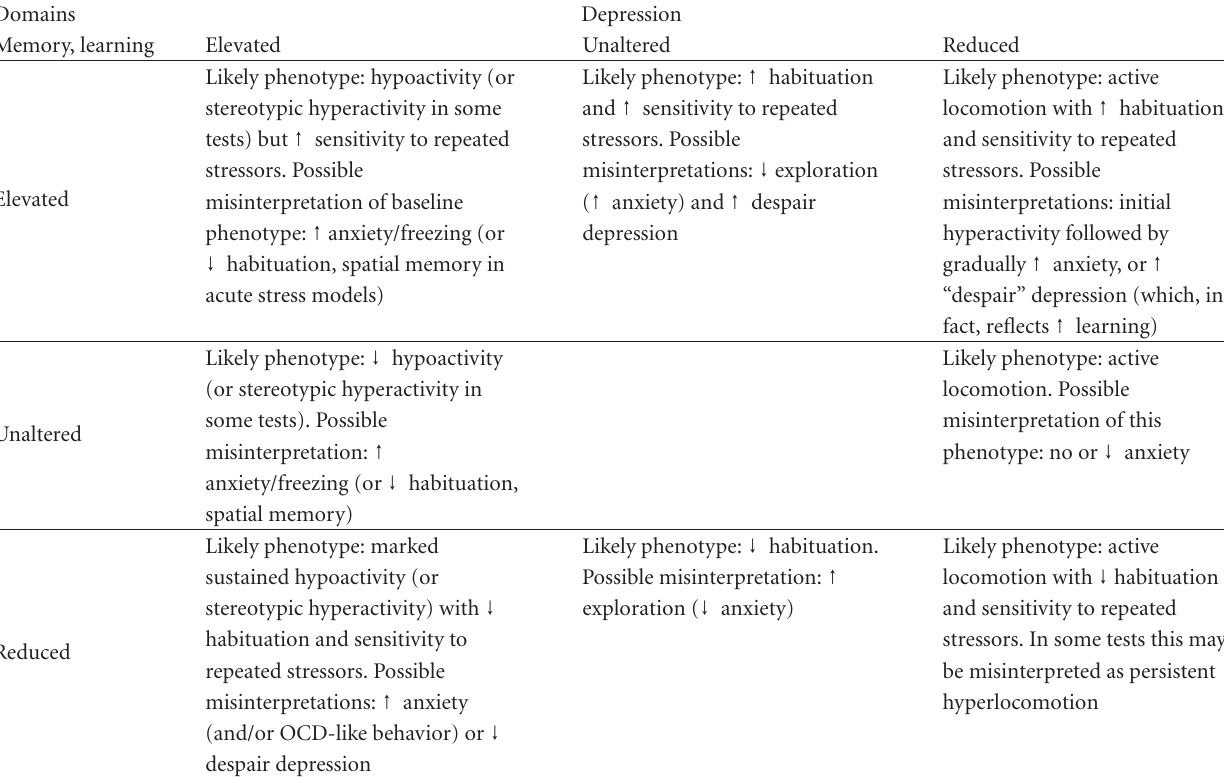
Table 2: Examples of possible interplay between memory and depression domains, that may lead to misinterpreted animal behavioral phenotypes (e ff ects: ↑ increased, ↓ reduced behavior; OCD-obsessive-compulsive disorder). Given high research pressure on behavioral labs, consider the likelyhood of incorrect interpretation of behavioral